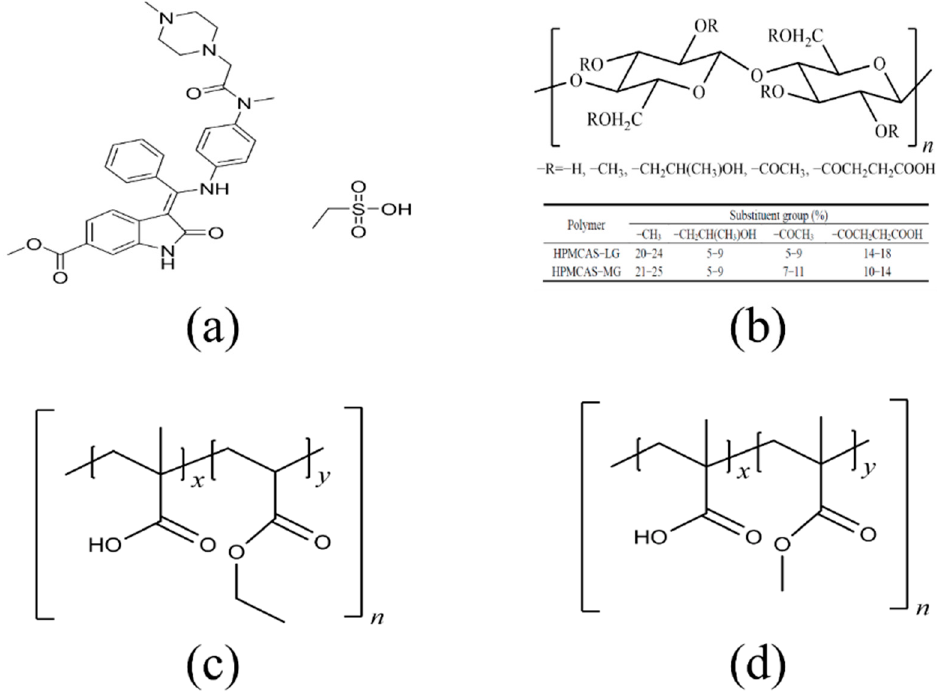
Figure 1. Molecular structures of ( a ) nintedanib (pKa = 7.9), ( b ) HPMCAS (LG and MG), ( c ) Eudragit L100 55, ( d ) Eudragit L100.